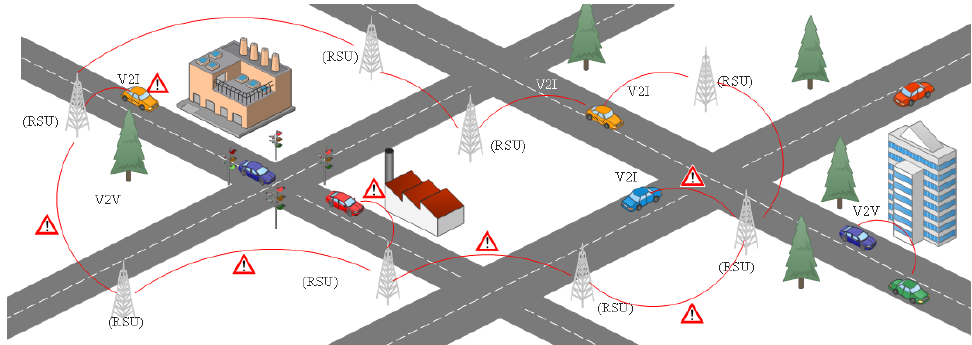
Figure 1. RSU detecting an attacker and forwarding information to other connected RSUs and